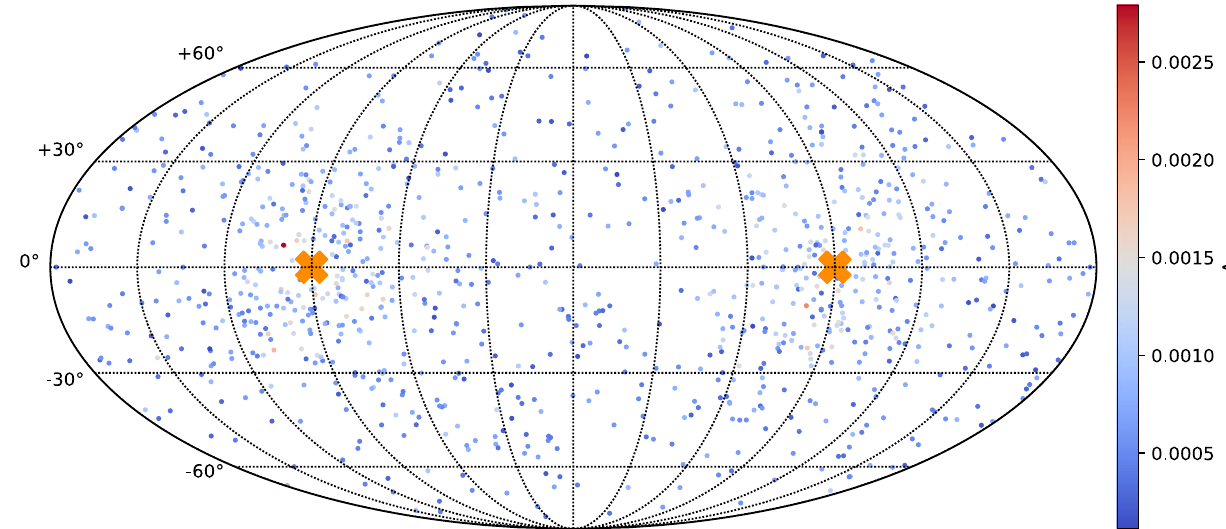
Fig. 16 Distribution of dipole directions of type B samples. Dipole directions concentrate near crossed positions